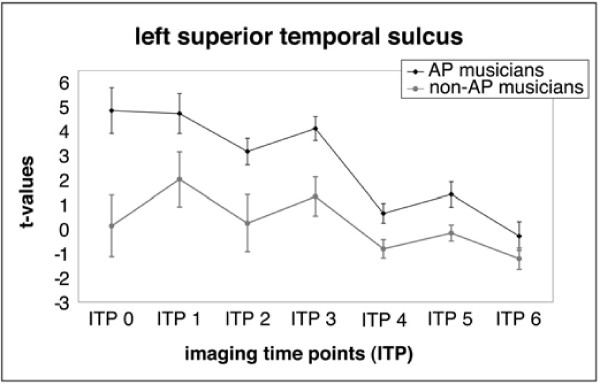
Time course of mean (SD) regional t-scores for the ROI in the left STS (error bars represent the between subject variability).